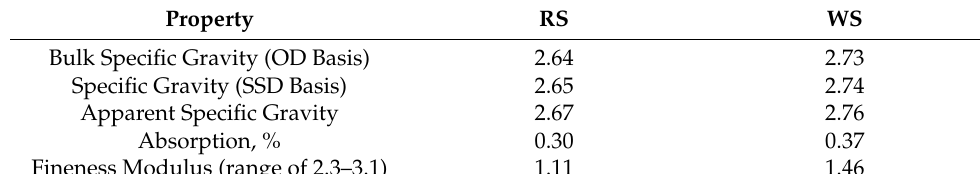
Table 2. Physical properties of RS and WS.